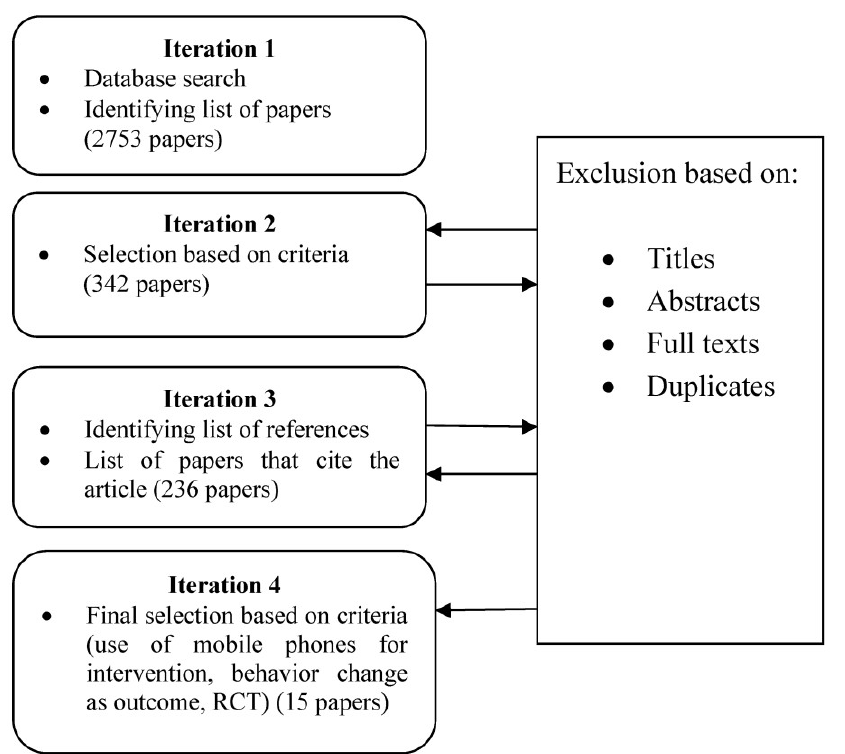
Figure 3. Selection of